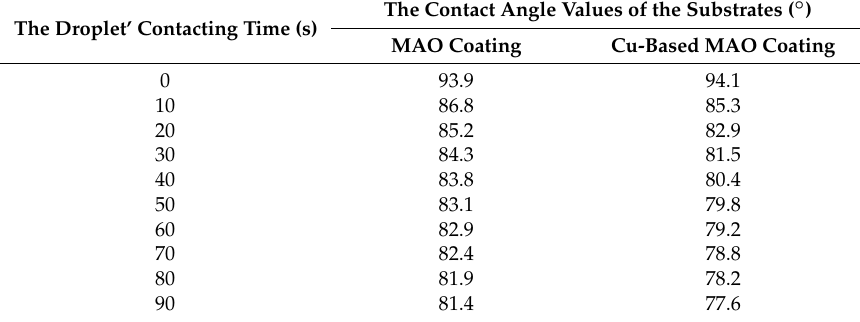
Table 3. The average contact angle values of the MAO and Cu-based MAO surfaces at post-contacting time of